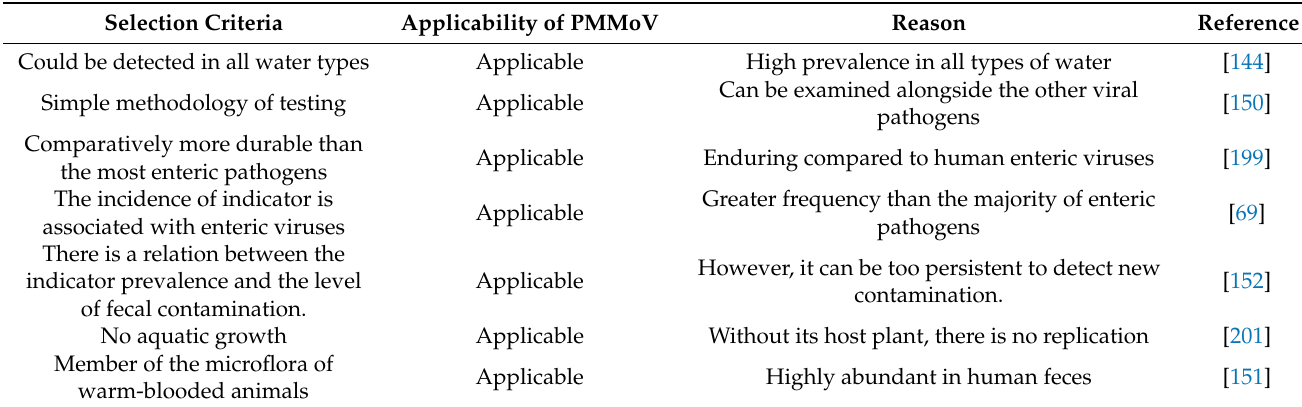
Table 3. Criteria for PMMoV as an ideal human fecal